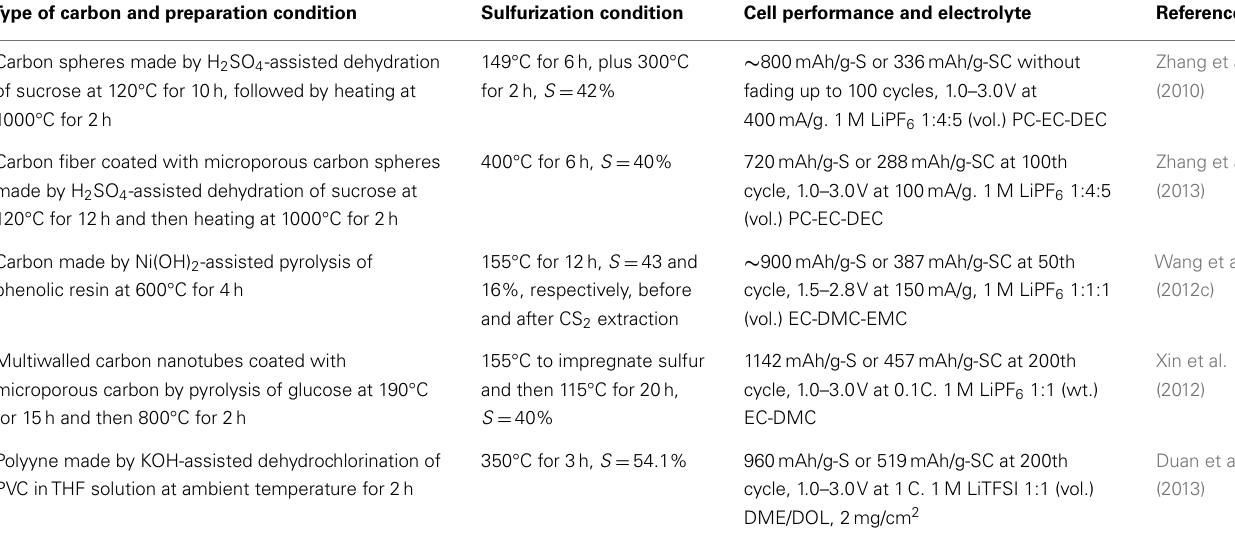
Table 1 | Preparation condition of carbon and SC and cycling performance of Li/SC